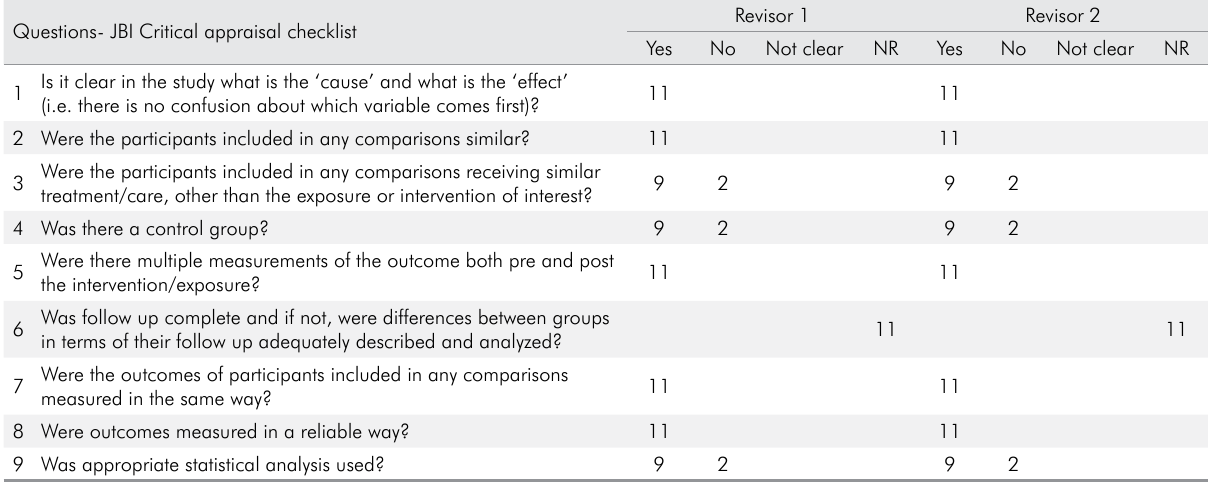
Table 3. Risk of bias – JBI critical appraisal checklist for quase-experimental studies (non-randomized experimental studies). Questions- JBI Critical appraisal